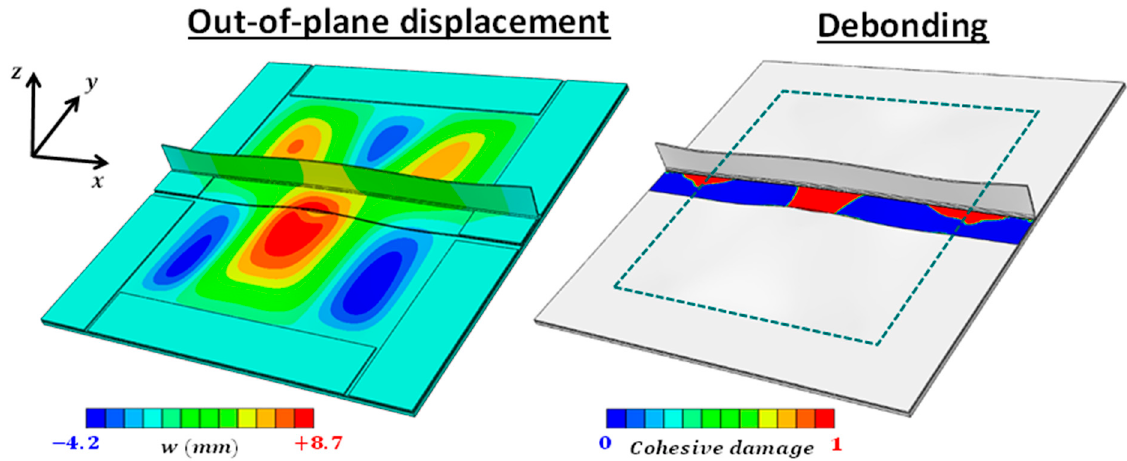
Figure 9. Simulation of the stiffened panel under compression, during the first steps of the global debonding from centre to border. ( left ) Out-of-plane displacement showing two arrays of compressive buckles; ( right ) debonding seen through the damage variable of cohesive elements.